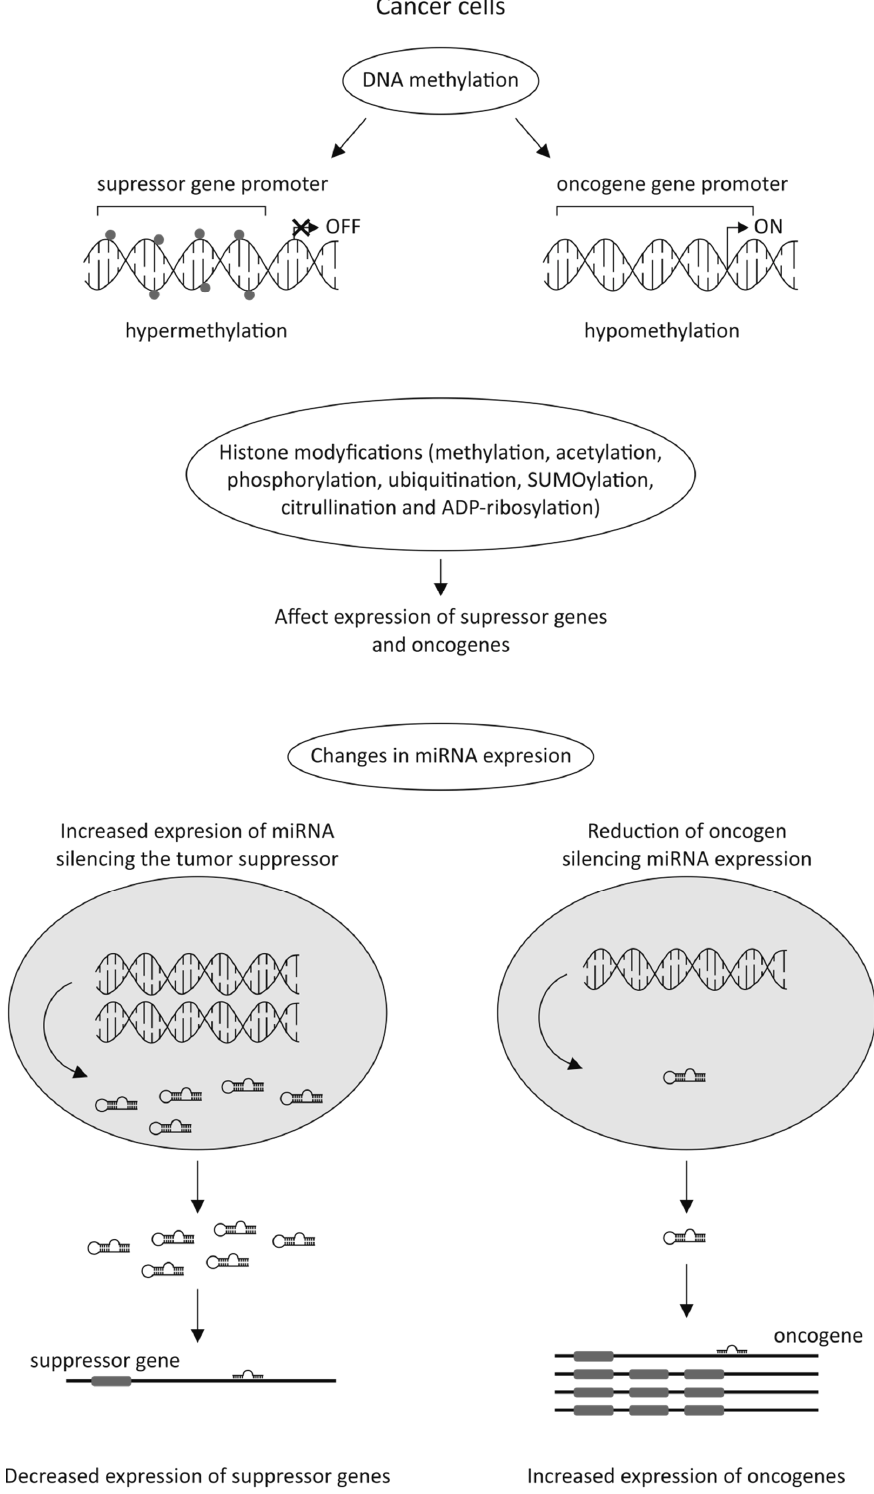
Figure 4. Cancer cell gene regulation by epigenetic alterations [50–52].